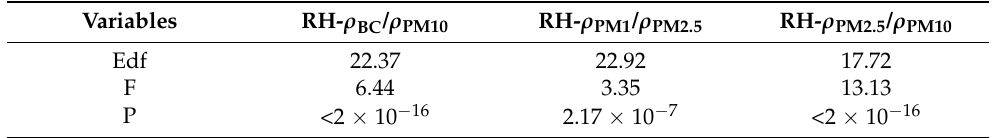
Table 7. Simulation results of the GAMs with the interaction effect.